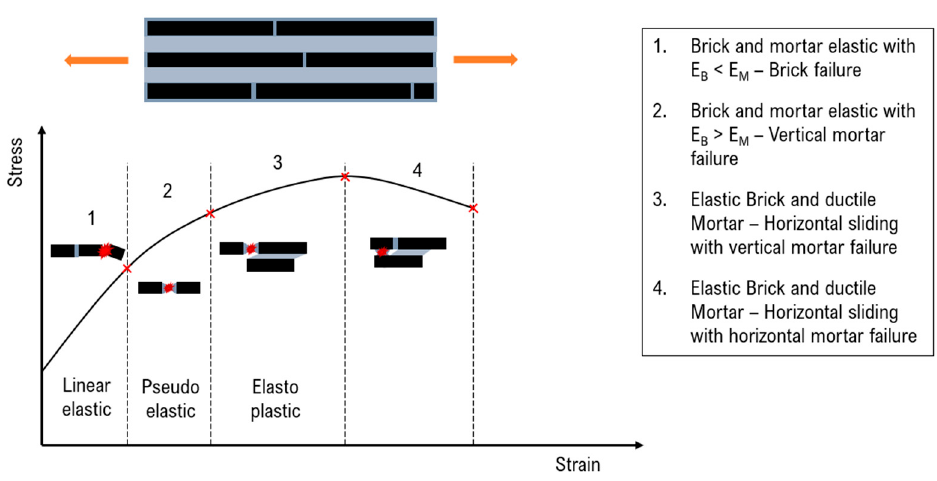
Figure 12. Stress–strain behaviour in tension of B&M composites.